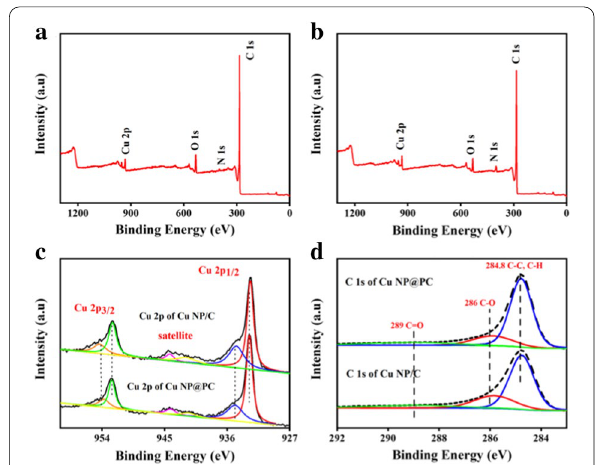
Fig. 3 a XPS survey spectrum of Cu NP@PC; b XPS survey spectrum of Cu NP/C; c Cu 2 p XPS spectra of Cu NP@PC and Cu NP/C; and d C 1 XPS spectra of Cu NP@PC and Cu